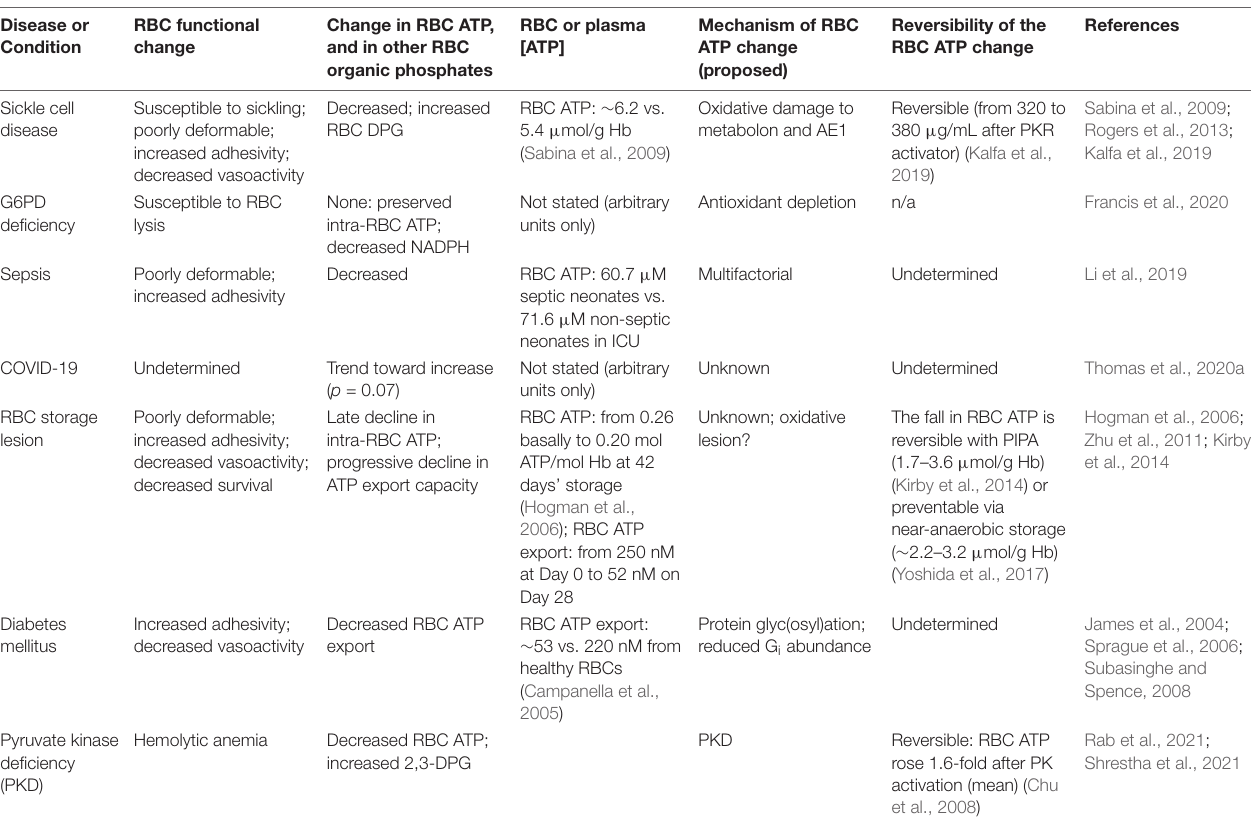
TABLE 1 | Changes in RBC function and RBC ATP in human